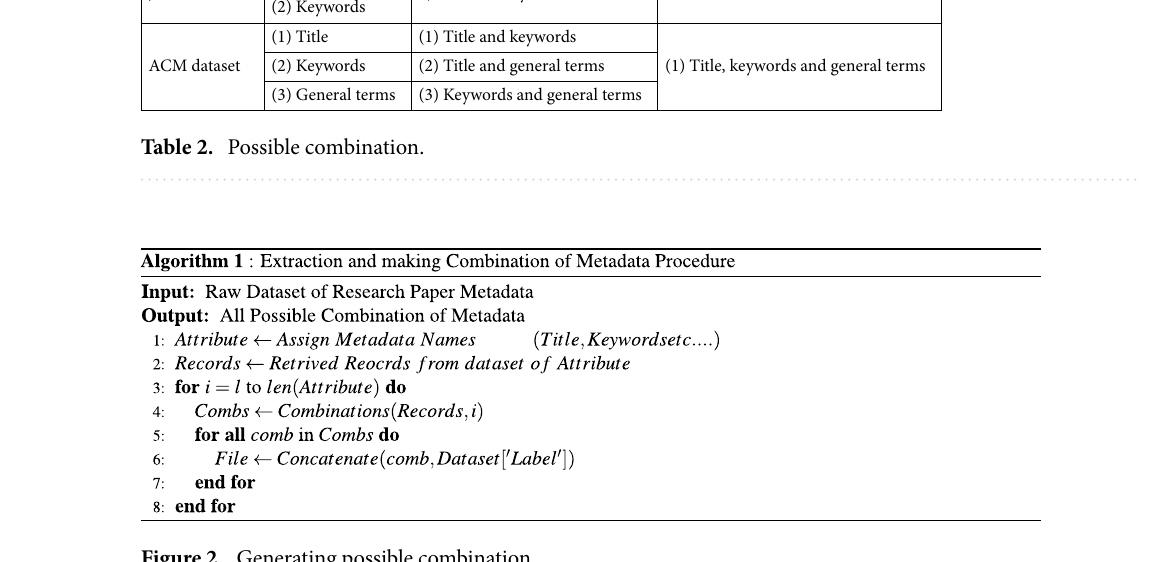
Figure 2. Generating possible